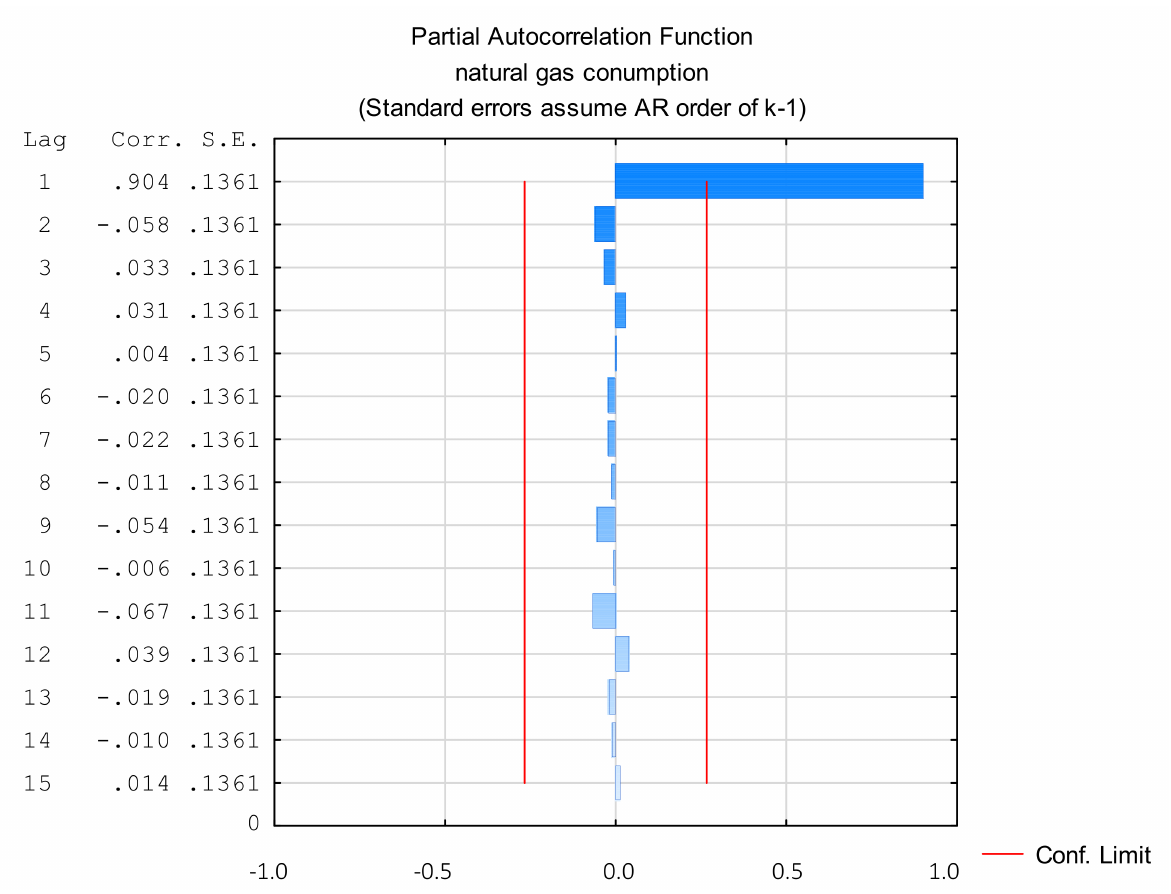
Figure 5. Partial autocorrelation function; own study based on